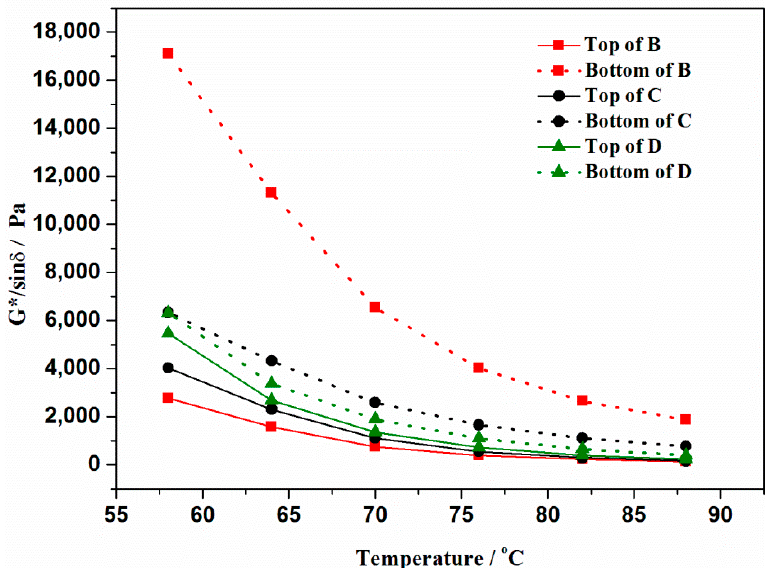
Figure 8. G*/sin δ of top and bottom samples of modified asphalt binder . Figure 8. G* / sin δ of top and bottom samples of modified asphalt binder.